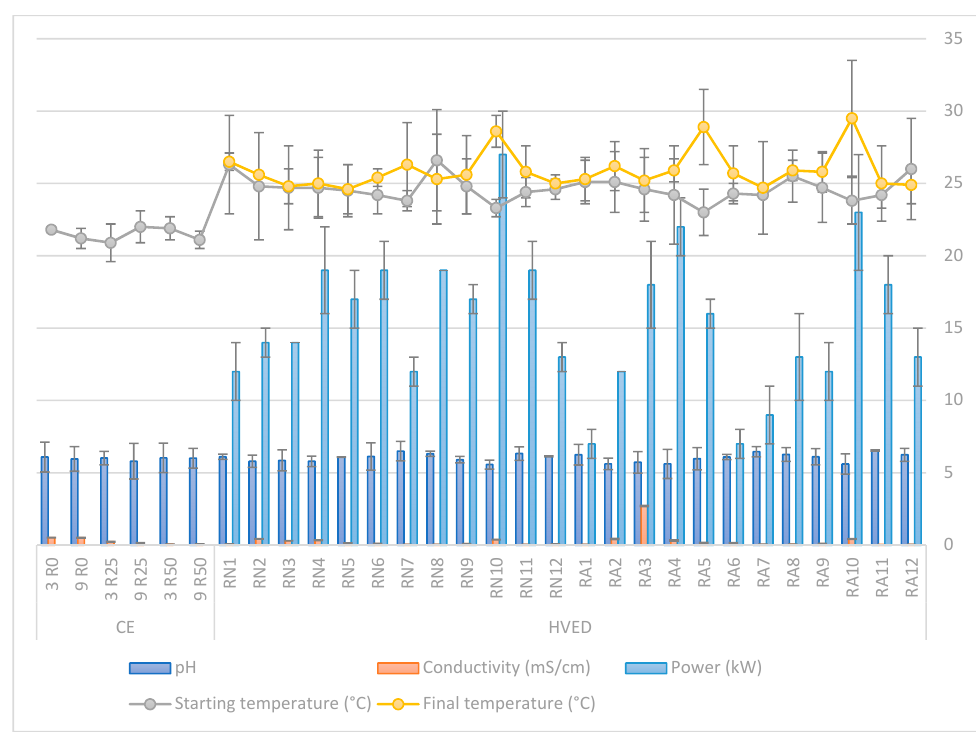
Figure 2. Values of pH, conductivity (mS/cm) for CE and HVED treated samples, starting temperature (°C), final temperature (°C) and power (kW) after HVED treatments.